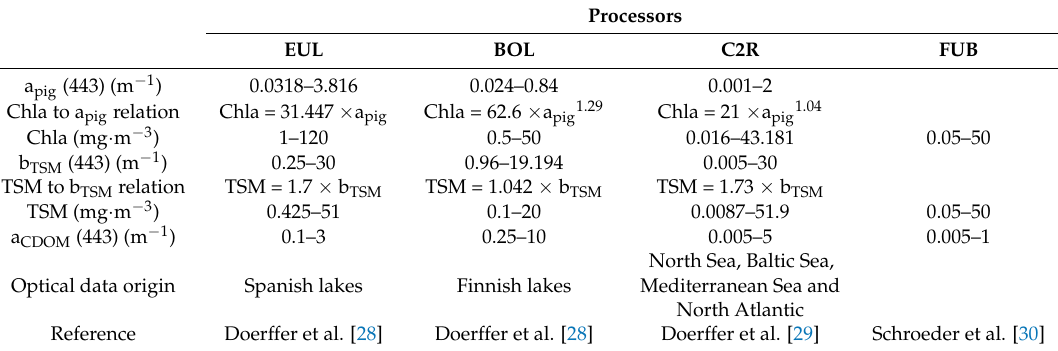
Table 3. The ranges of inherent optical properties and concentrations used to train the neural network of Eutrophic Lake (EUL), Boreal Lake (BOL), Case 2 Regional (C2R), and the Free University of Berlin (FUB)